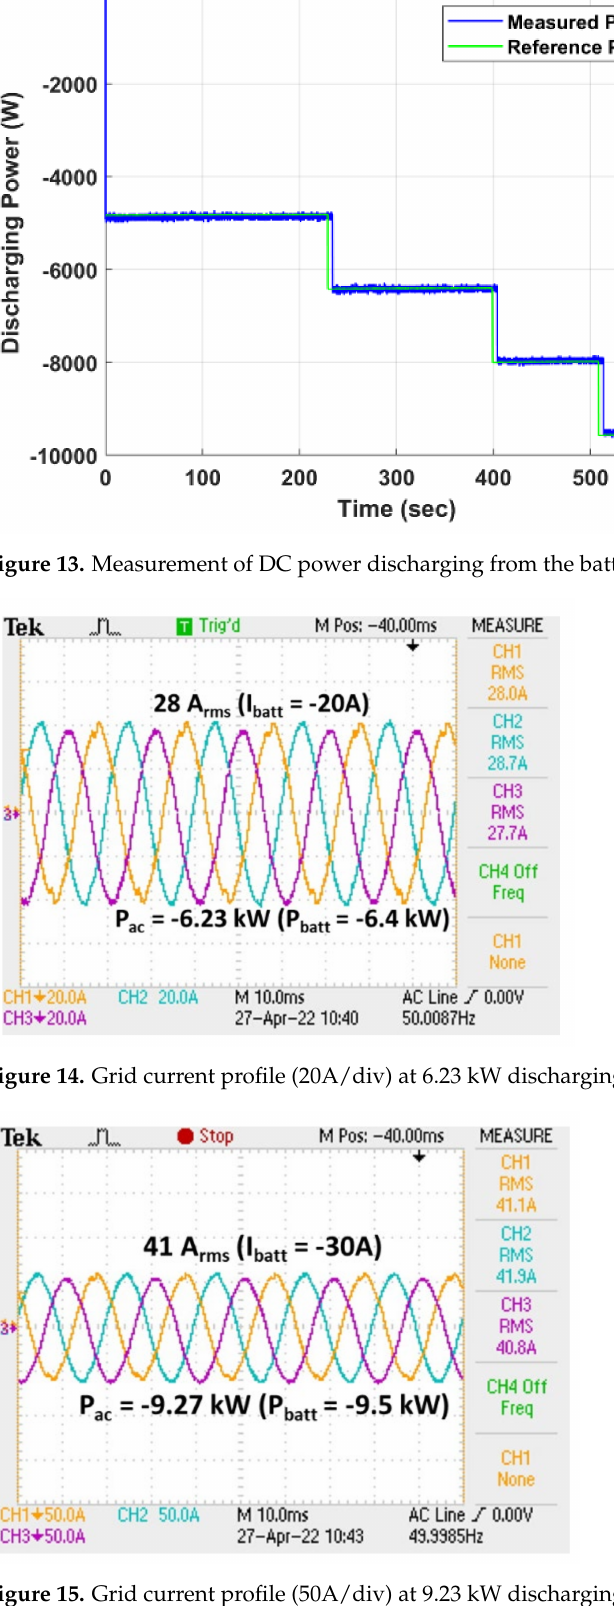
Figure 15. Grid current profile (50A/div) at 9.23 kW discharging